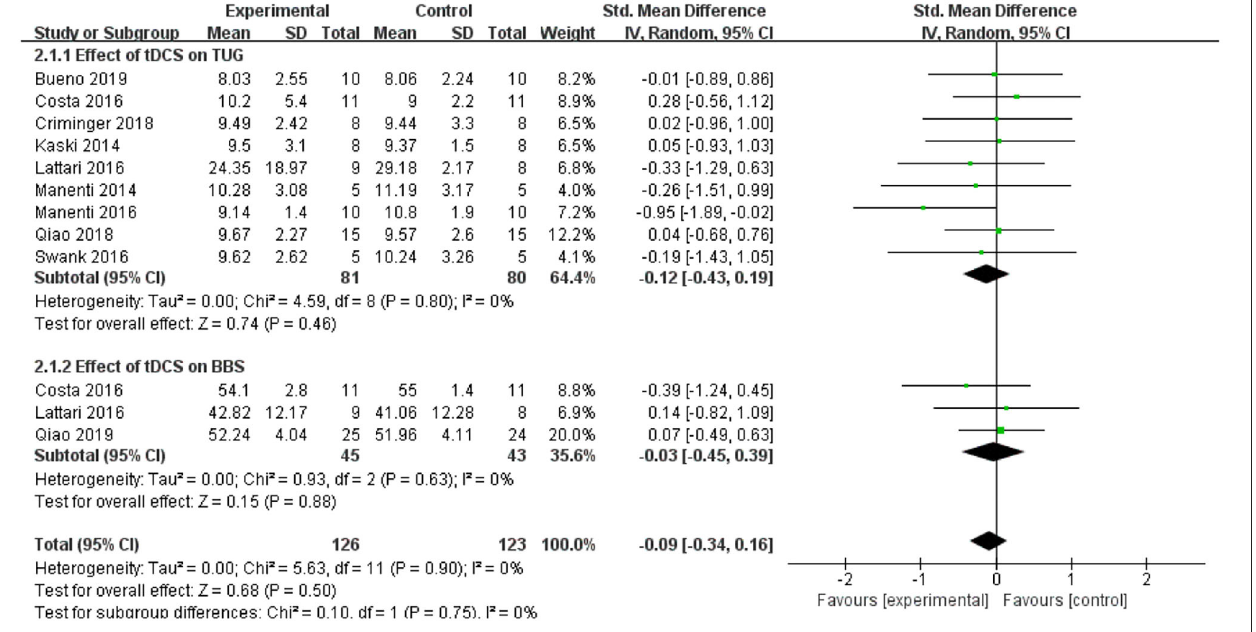
FIGURE 7 | Forest plot of TUG and BBS. As shown in the Figure, tDCS did not improve the performance in the TUG and BBS significantly. BBS, Berg balance scale; CI, confidence intervals; SD, standard deviation; tDCS, transcranial direct current stimulation; TUG, timed up and go